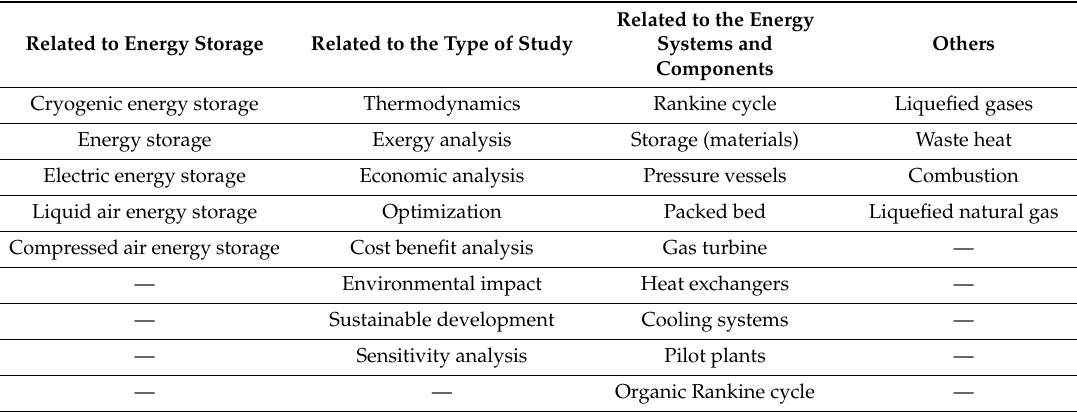
Table 4. List of the main keywords divided in di ff erent categories from the Scopus database.